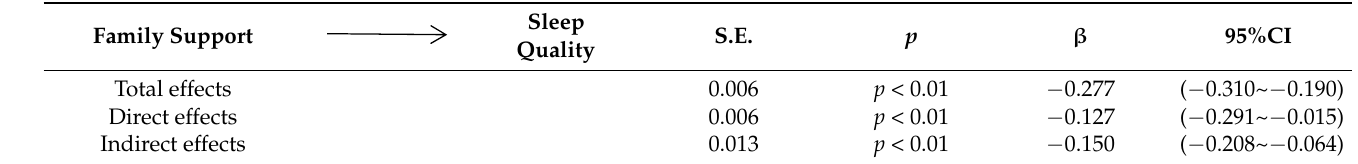
Table 3. Mediating effect of stress on the relationship between family support and sleep quality (n = 660).